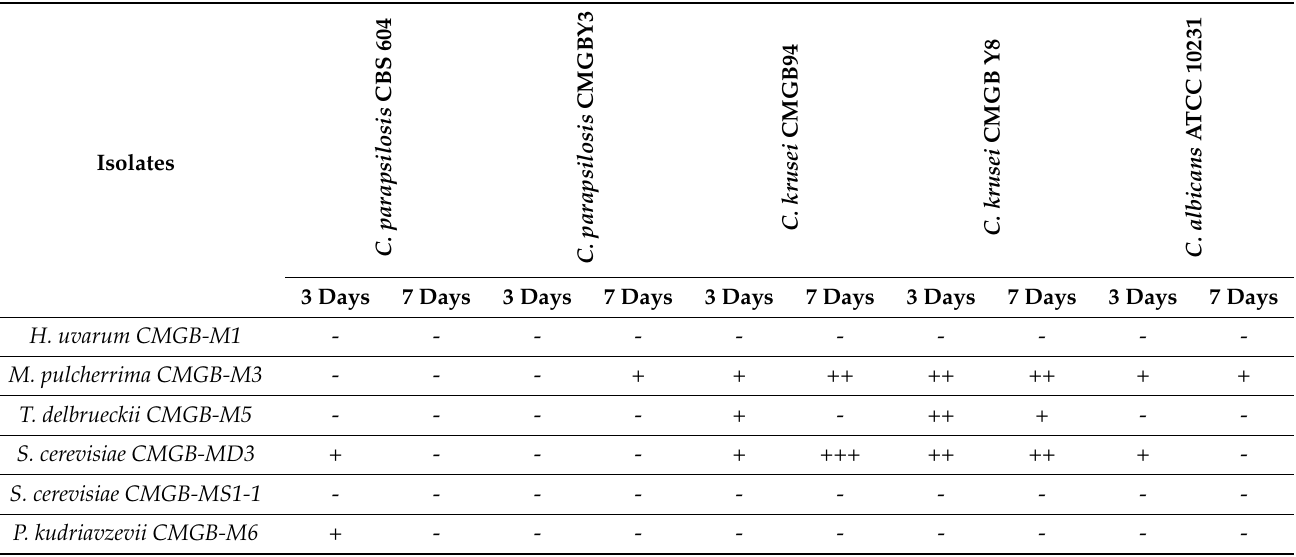
Table 6. Highlighting the antimicrobial activity in the presence of low pH values against Candida strains at 3 and 7 days of incubation on medium